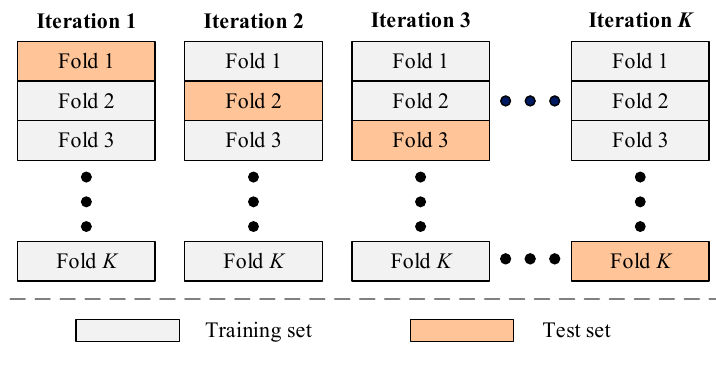
Figure 5. K -fold cross-validation technique.